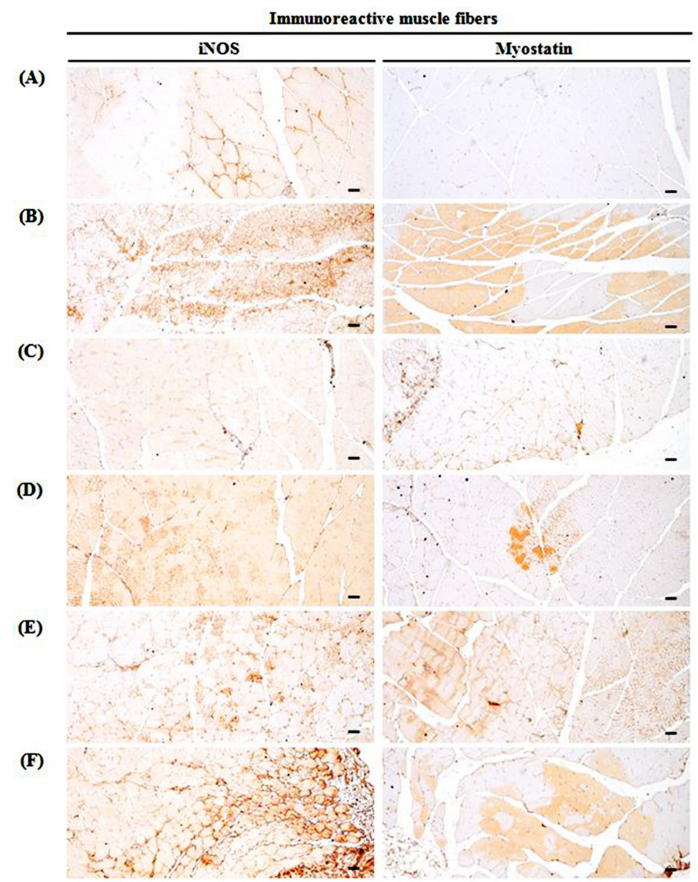
Figure 10. Selective gastrocnemius muscle iNOS and myostatin-immunoreactivity. ( A ) Intact vehicle control (distilled water administered and treated with saline). ( B ) GLU control (distilled water administered and treated with DEXA). ( C ) Oxymetholone (50 mg/kg oxymetholone administered and treated with DEXA as reference). ( D ) TCcp500 (500 mg/kg TCcp administered and treated with DEXA–higher dose treated mice). ( E ) TCcp250 (250 mg/kg TCcp administered and treated with DEXA–middle dose treated mice). ( F ) TCcp125 (125 mg/kg TCcp administered and treated with DEXA–low dose treated mice). TCcp = tart cherry (Fruit of Prunus cerasus L., Rosaceae)